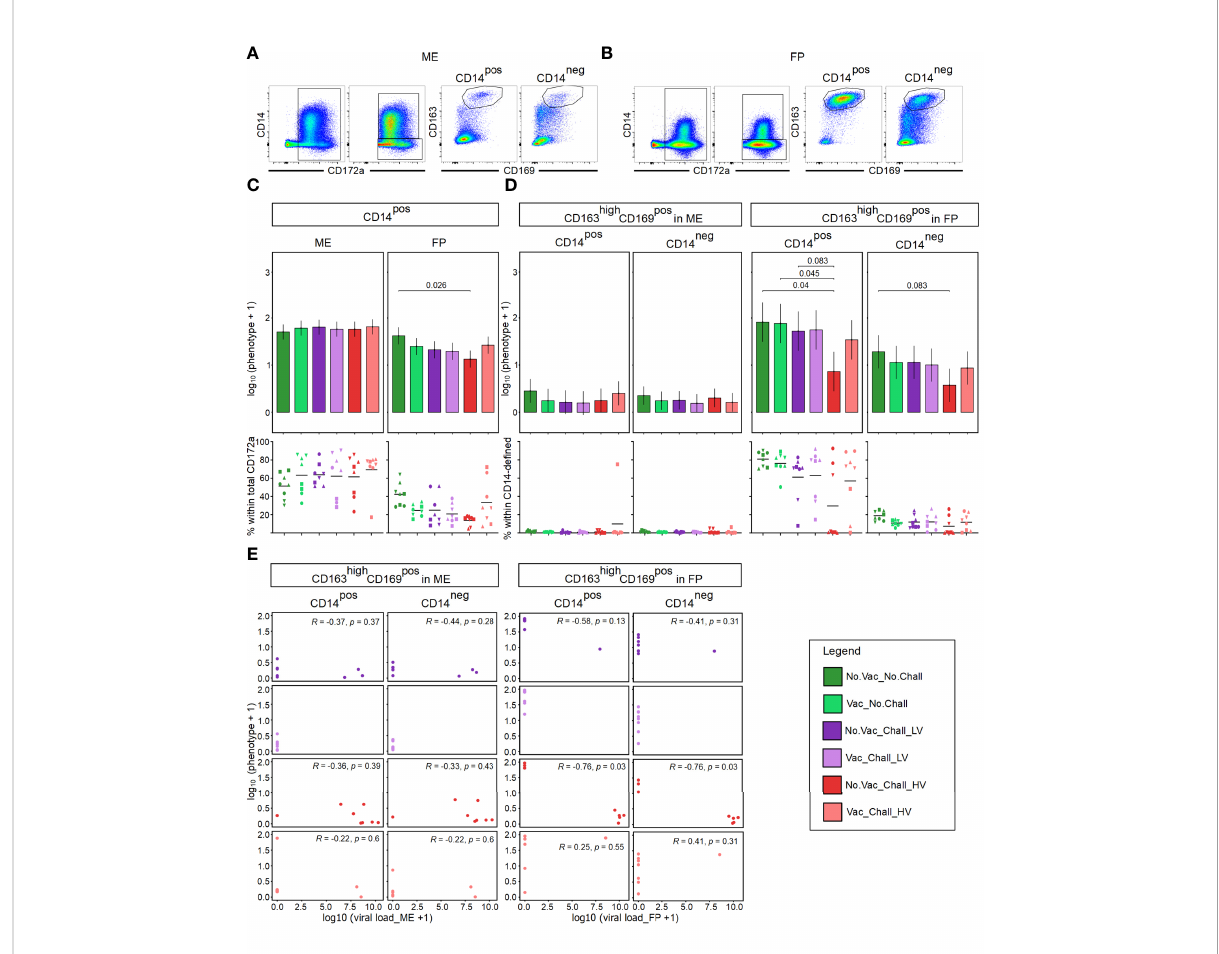
FIGURE 2 Mononuclear phagocytes at the maternal-fetal interface and their correlation to viral load. (A, B) A time gate was applied and mononuclear phagocytes (MPCs) were gated based on their SSC-A (side scatter area) versus FSC-A (forward scatter area) characteristics and following a consecutive gating strategy was applied to exclude doublets, cells with high auto fl uorescence, and dead cells (Supplementary Figure 1). MPCs were further analyzed for their expression of CD172a and subsequently sub-gated for CD14 pos CD172a pos and CD14 neg CD172a pos MPCs. The two CD14- de fi ned MPC populations were further analyzed for their co-expression of CD163 and CD169. For both CD14-de fi ned MPCs a CD163 high CD169 pos subset was identi fi ed at the maternal fetal interface. Representative pseudocolor plots from the maternal endometrium (ME) in (A) and fetal placenta (FP) in (B) from a No.Vac_No.Chall fetus are shown. (C) A linear mixed effects model considering the fi xed effects of treatment, tissue, and the interaction between both was applied. A random intercept (gilt) was fi tted and estimated marginal means (emmeans) were calculated. Results for total CD14 pos MPCs within the ME (left) and FP (right) are presented as bar plots on top. On the y-axes the estimated marginal means (emmeans) for CD14 pos MPCs on a log 10 scale, after adding a constant of + 1, are depicted. The graphs below depict the frequency of CD14 pos MPCs within total CD172a pos cells for the individual fetuses within each treatment group in the ME (left) and FP (right). (D) A linear mixed effects model considering the fi xed effects of treatment, tissue, and the interaction between both was applied. A random intercept (gilt) was fi tted and estimated marginal means (emmeans) were calculated. Results for CD163 high CD169 pos MPCs within CD14 pos and CD14 neg cells within the ME (left) and FP (right) are shown. The y-axes in the bar plots (on top) represent the emmeans of the CD163 high CD169 pos MPCs within CD14-de fi ned subsets on a log 10 + 1 scale. The frequencies of the CD163 high CD169 pos MPCs within CD14-de fi ned subsets for the individual fetuses and anatomic locations are given in the graphs below. For all bar plots only signi fi cant p-values (p < 0.1), corrected for multiple testing using a false discovery rate approach across all 234 pairwise comparisons of contrasts, are shown above the brackets. The whiskers depict the 95% con fi dence intervals of the emmeans. For all graphs showing the frequencies of a speci fi c cell subset, results for the fetuses from one gilt are represented by different symbols. The black bars in the graphs display the mean within the respective treatment group within the speci fi ed anatomic location. (E) Spearman correlation coef fi cients were estimated, to investigate the relationship between log 10 transformed CD163 high CD169 pos CD14-de fi ned MPCs and log 10 transformed viral load, for all challenged groups and both anatomic locations. Results for the spearman correlation in the ME are shown on the left and FP on the right. The correlation coef fi cients (R) and p-values (p < 0.1) not corrected for multiple testing are depicted. For all bar plots, graphs, and scatterplots the depicted treatment groups are: No.Vac_No.Chall (dark green, non-vaccinated and non-infected), Vac_No.Chall (light green, vaccinated and non- infected), No.Vac_Chall_LV (dark purple, non-vaccinated and infected low virulent strain), Vac_Chall_LV (light purple, vaccinated and infected low virulent strain), No.Vac_Chall_HV (dark red, non-vaccinated and infected high virulent strain), and Vac_Chall_HV (light red, vaccinated and infected high virulent